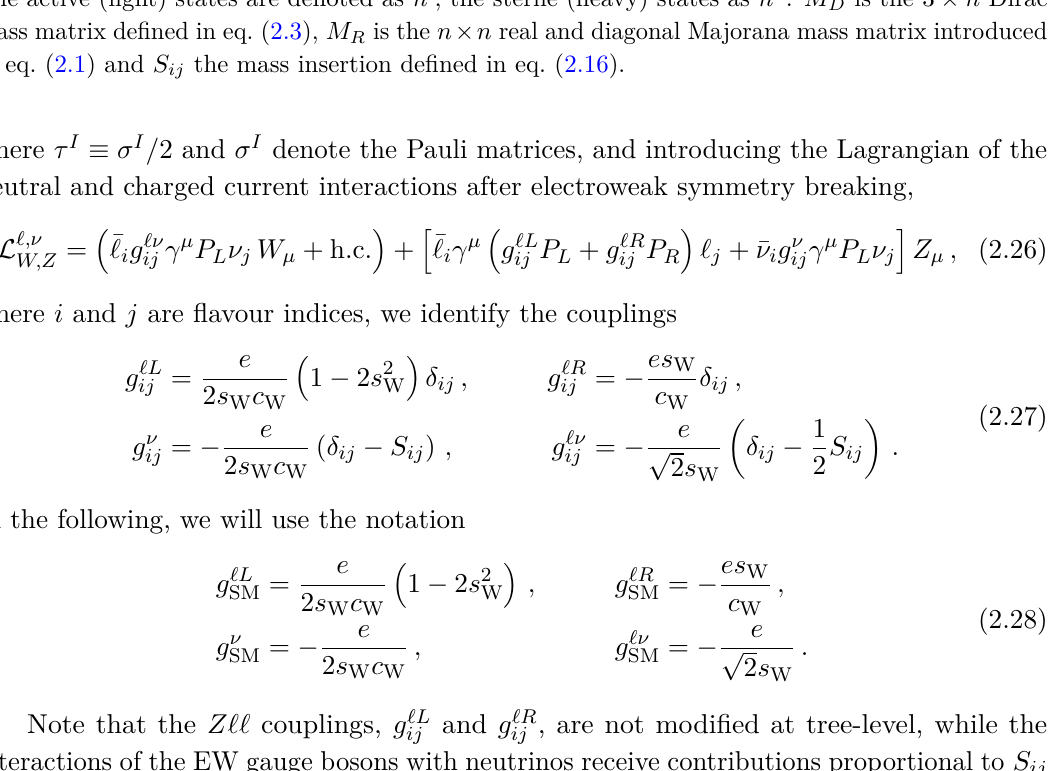
is the 3 × n Dirac D